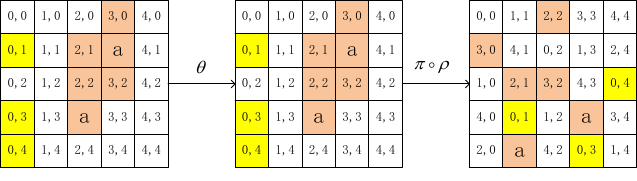
Figure 20: Attack on 5-round Ketje Jr v2